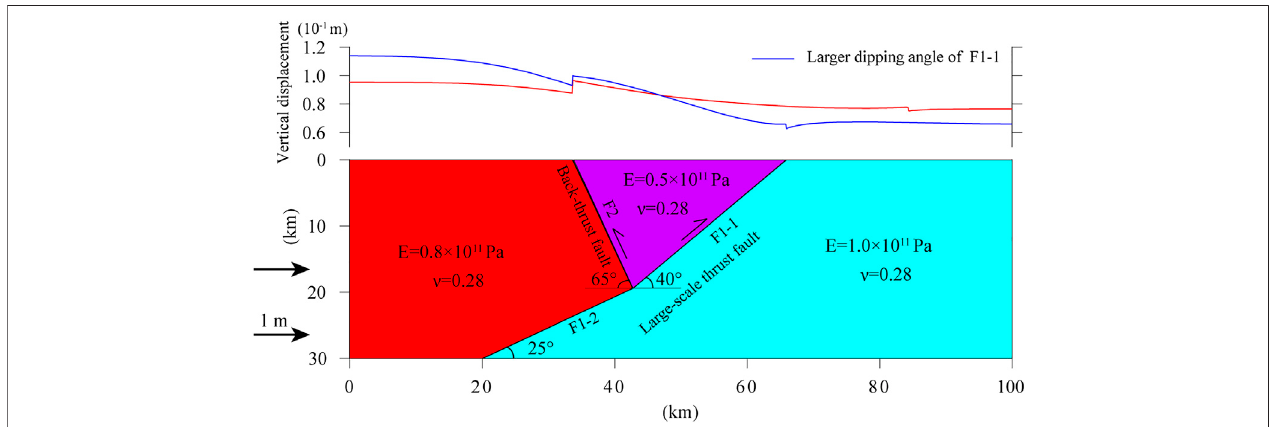
FIGURE9| Impactoffaultdippinganglechangeontheverticalsurfacedeformation.Theredlineintheupperpanelrepresentsthesameverticaldisplacementasin Figure 8C .